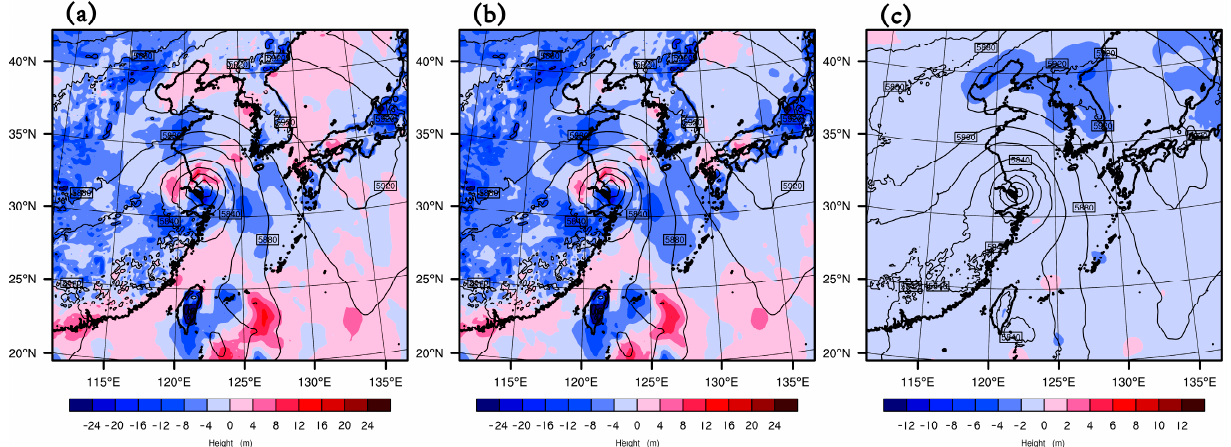
Figure 9. Geopotential height increment of ( a ) GTS, ( b ) MWHS2, and ( c ) the difference between GTS and MWHS2.